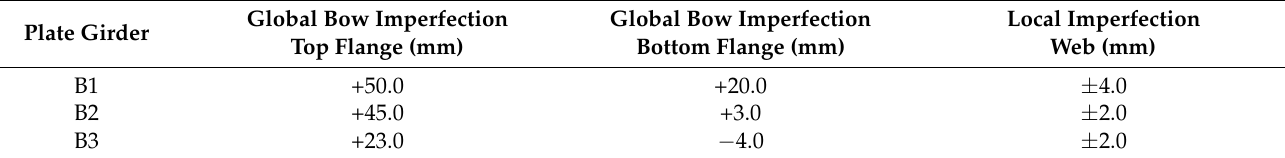
Table 5. Permanent deformations after cooling phase (+/ − indicates the direction of the imperfection). Plate